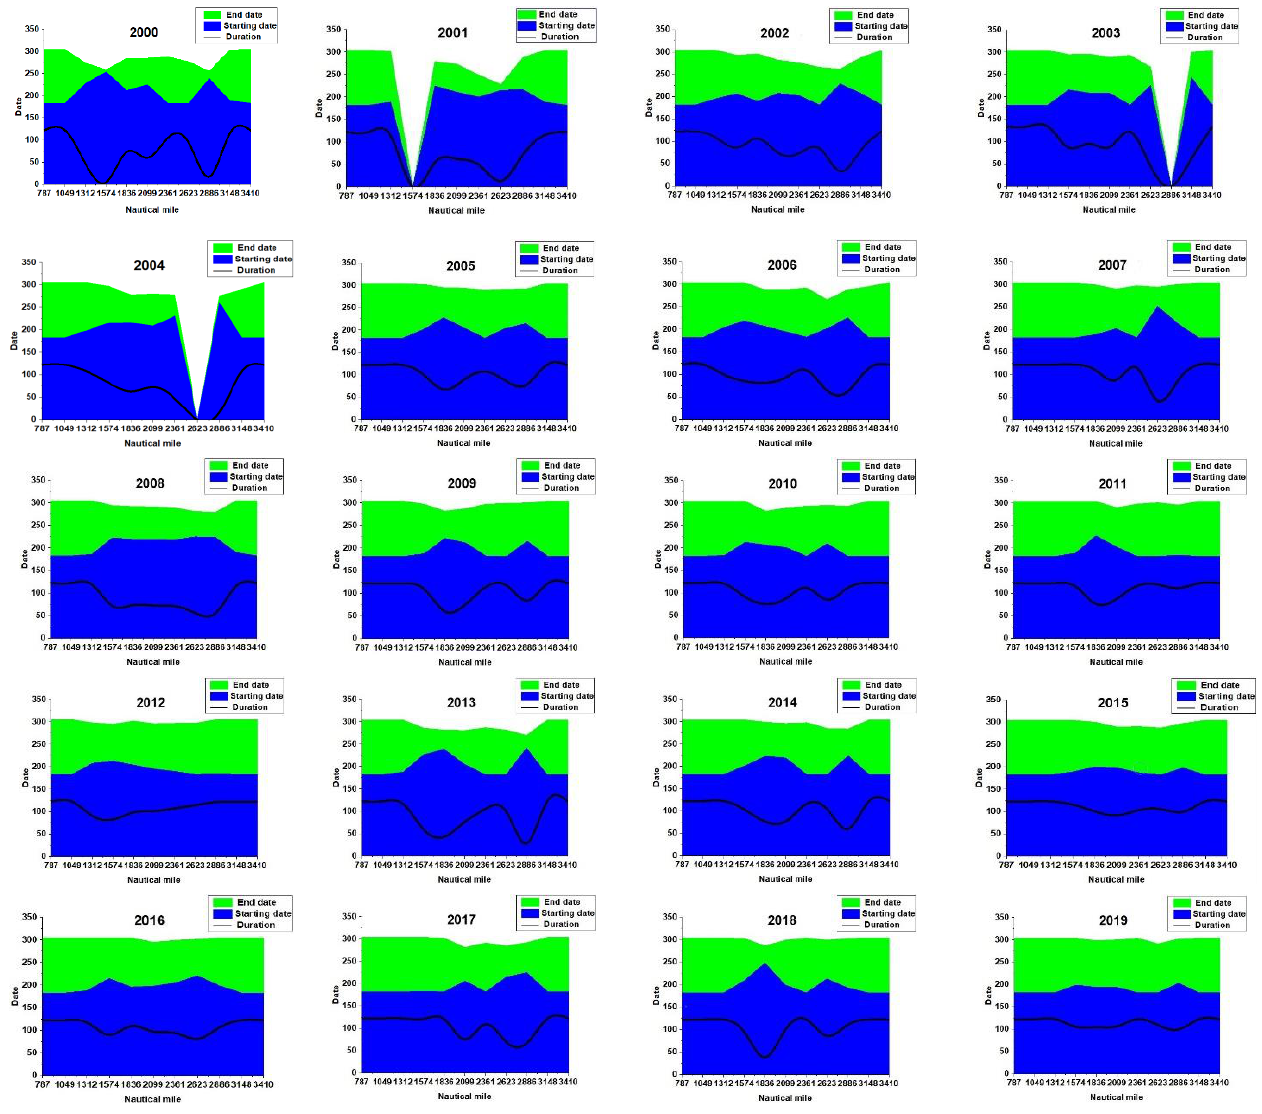
Figure 6. The start and end time and duration of the navigation of the NEP from 2000 to 2019. The blue area indicates the start date of navigation of the NEP that year, the green area indicates the end date, and the solid black line indicates the navigation duration of the current year. Table 1. Navigation schedule of the NEP from 2000 to 2019.